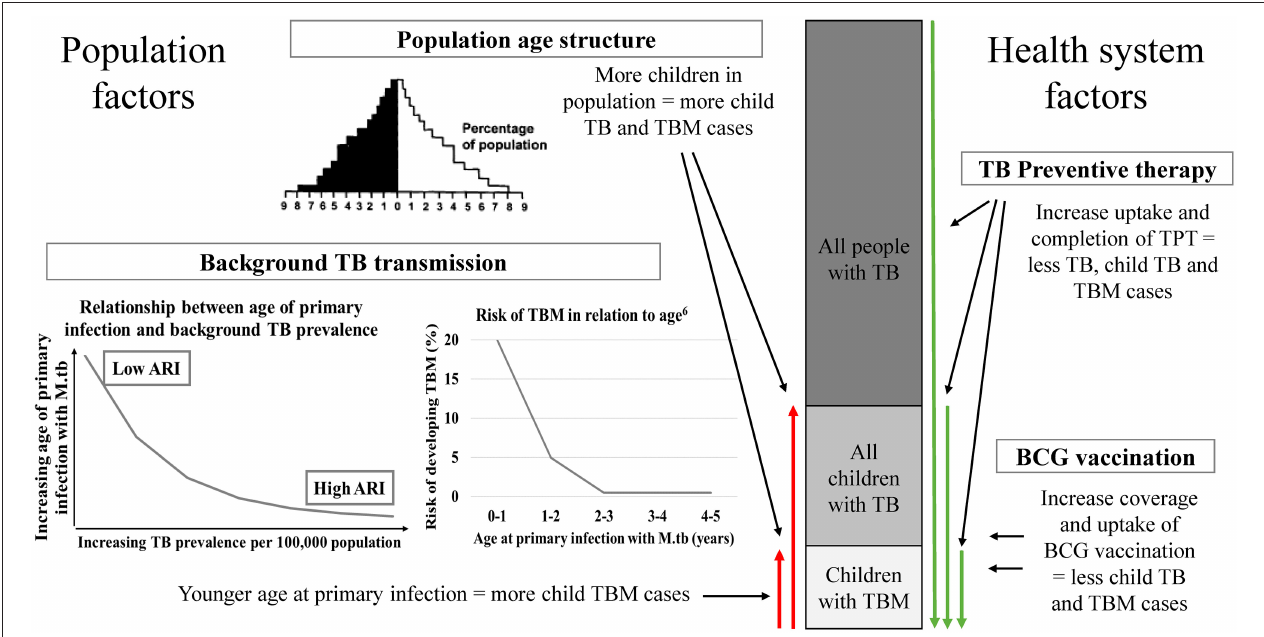
FIGURE 1 | A conceptual overview of the impact of relevant population and health system factors on the relationship between pediatric TBM, pediatric TB and all TB in a population. Population age structure —high TB burden countries often has a broad-base population pyramid with a large percentage of the population being children. Background TB transmission —The higher the TB prevalence in a population, the younger the age of primary infection with M.tb . Following primary infection, children < 2 years of age are at high risk of developing TBM (6). TB preventive therapy and BCG vaccination are two health system factors that influence the risk of TBM in children in a population. TB, tuberculosis; TBM, tuberculous meningitis; M.tb, Mycobacterium tuberculosis ; ARI, annual risk of infection; TPT, TB preventive therapy; BCG, Bacille